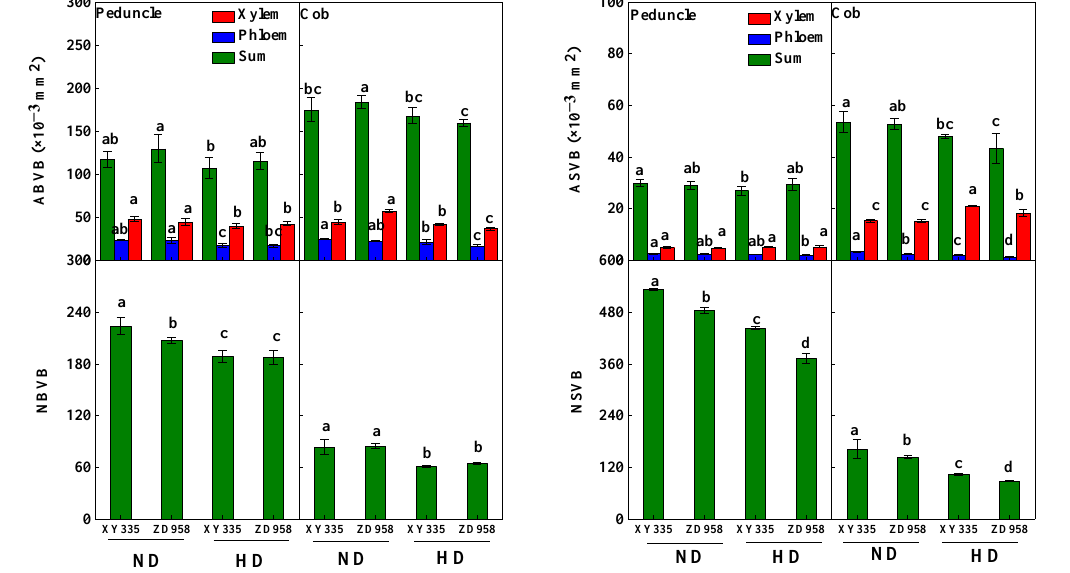
Figure 5. Effect of plant density on the area and number of big and small vascular bundles in two maize hybrids grown at maize milking stage in 2018. ABVB and ASVB, area of big and small vascular bundle; NBVB and NSVB, number of big and small vascular bundle. ND and HD indicate 60,000 and 90,000 plants ha − 1 density, respectively. Bars denote standard error ( n = 3). Letters indicate statistically significant differences in same position at p < 0.05 between treatments.